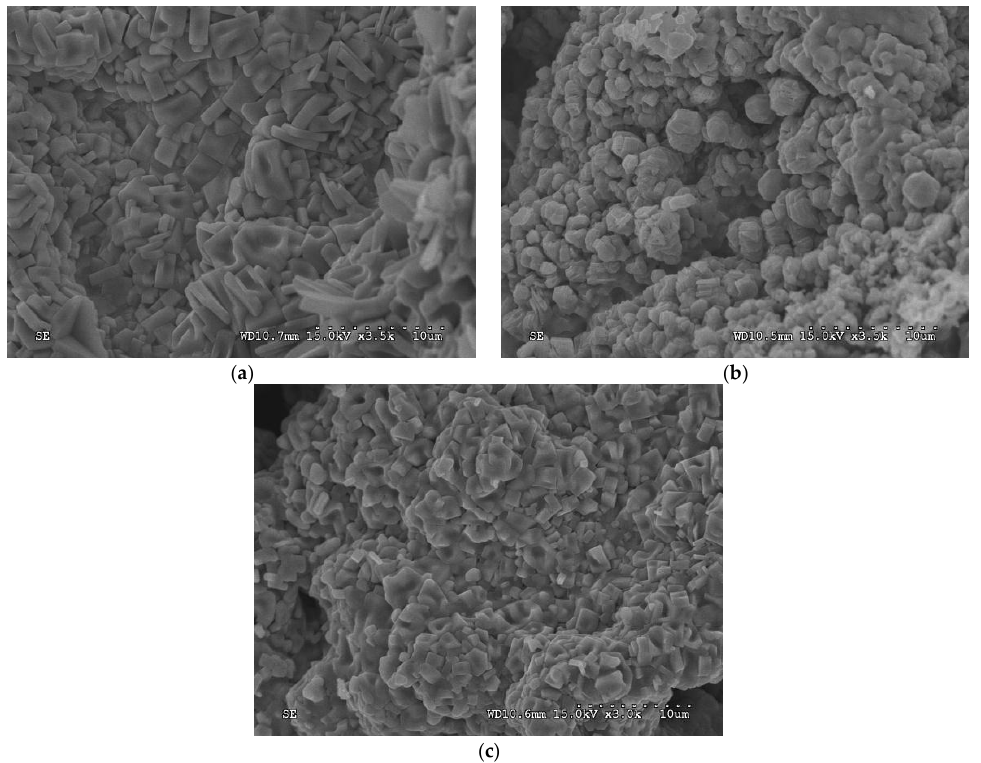
Figure 6. SEM micrographs of SHS-derived composites from samples with stoichiomerties of ( a ) 3Ti + B 4 C, ( b ) 2Ti + B 4 C + Cr, and ( c ) 2Ti + B 4 C + W.